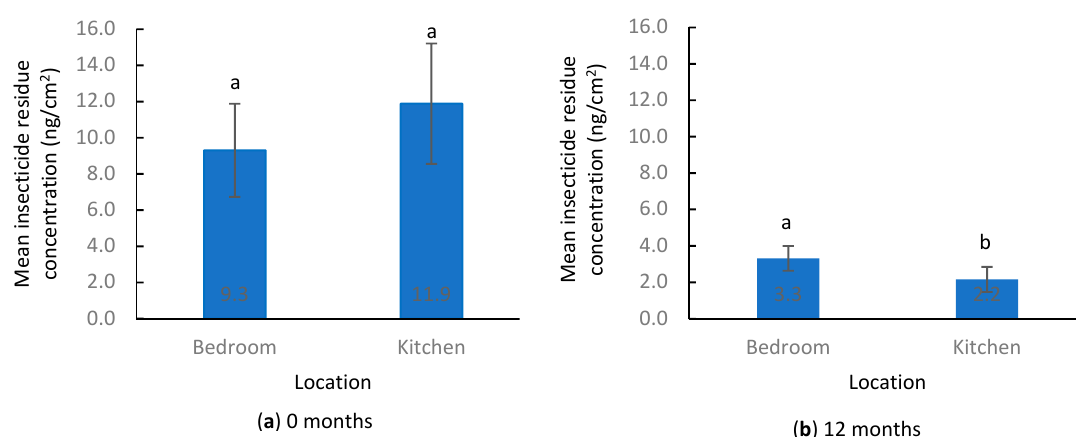
Figure 5. Insecticide residue concentration in settled floor dust before and after IPM program implementation. ( a ) 0 months, ( b ) 12 months. Different lowercase letters above the bars indicate significant differences between room type (Wilcoxon signed-rank test, p < 0.05).